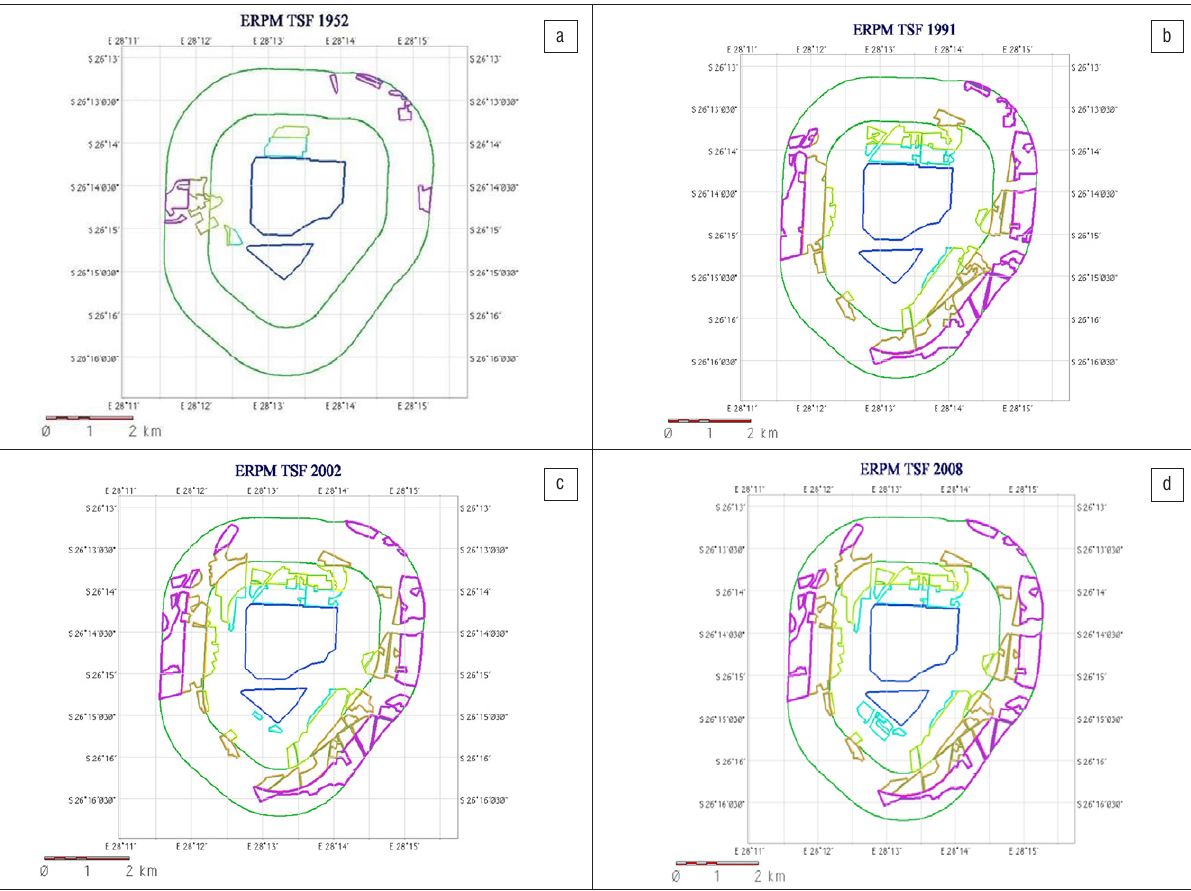
Figure 6: Time series progression of residential developments around the East Rand Proprietary Mine tailings storage facilities: (a) 1952; (b) 1991; (c) 2002 and (d) 2008, cyan ≤ 500 m; yellow between 500 m and 1 km; orange between I km and1.5 km; cerise between 1.5 km and 2 km; purple = tailings storage facilities (TSF)